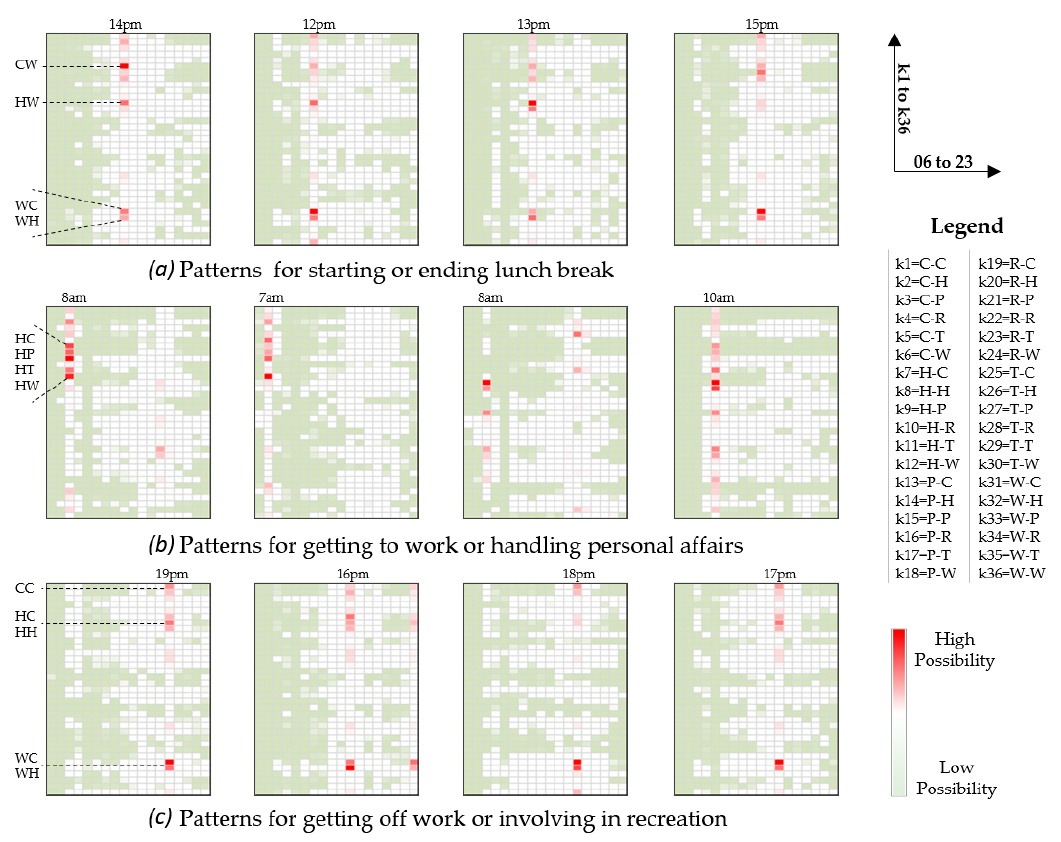
Figure 14. Working- and housing-related mobility patterns of the weekday (week